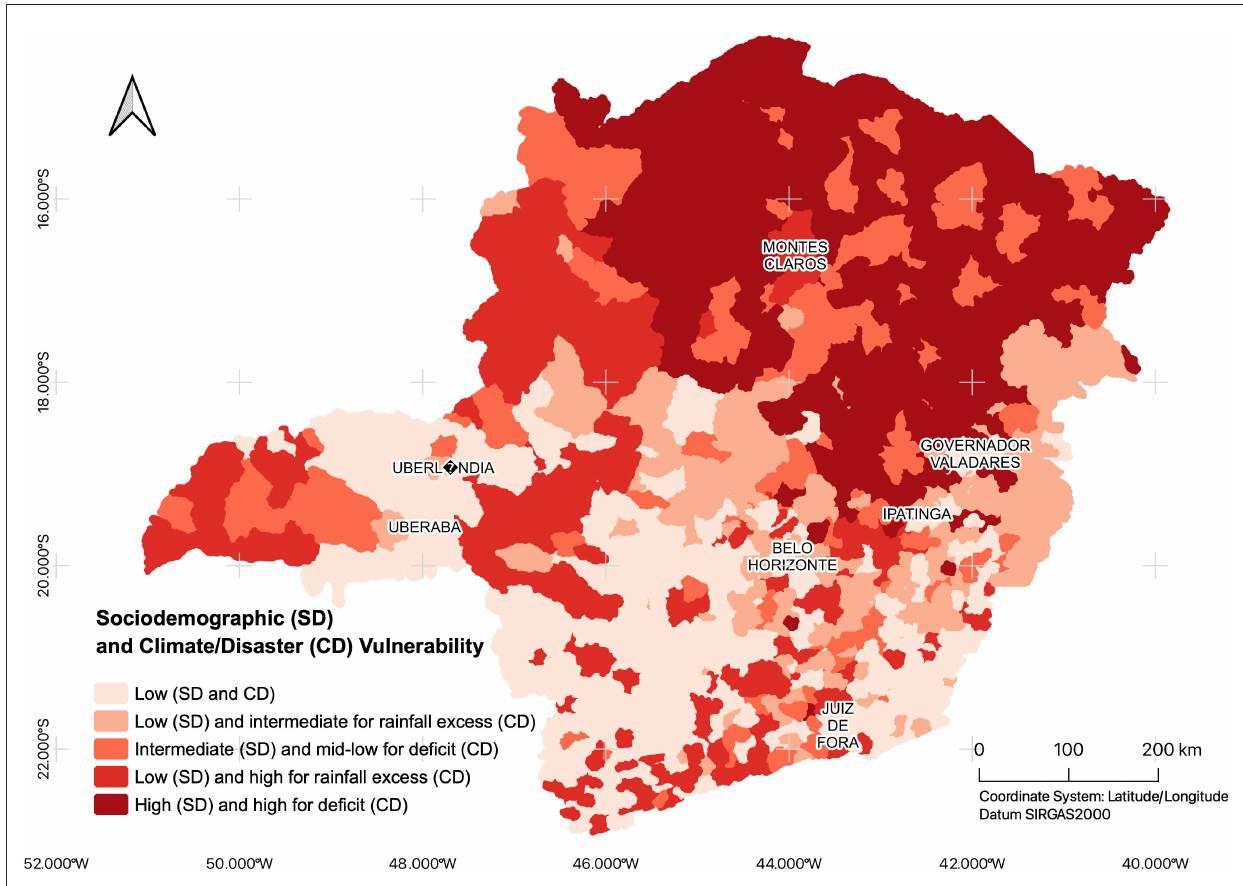
FIGURE4 Sociodemographic and climate-adjusted disaster vulnerability zoning in Minas Gerais, Brazil. Source: Anderson et al. (2013), Instituto Brasileiro de Geografia e Estatística – IBGE (2020), and The Climdex Project— Xavier et al.